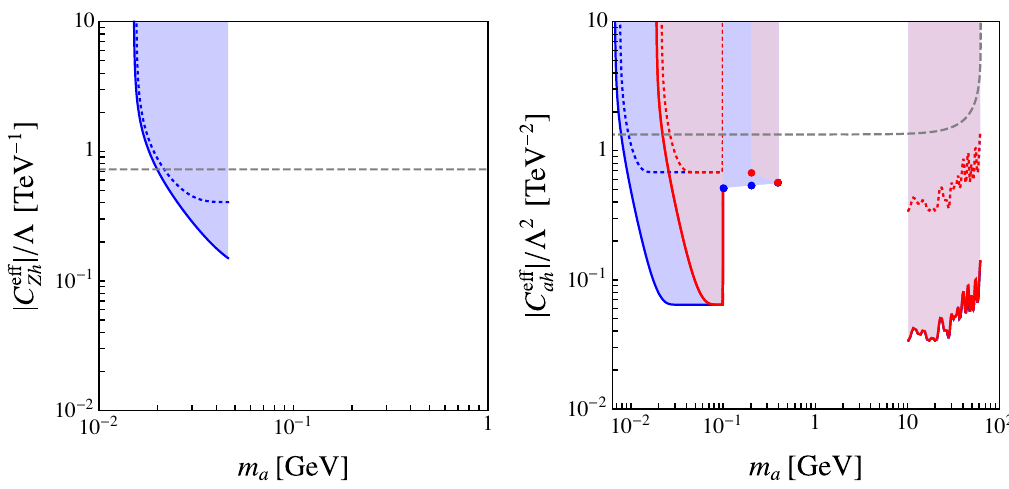
Figure 12 . Parameter space excluded by existing searches for h measurements of the pp h (cid:13)(cid:13) rate (low-mass region in the right panel), and by dedicated ! ! searches for h (cid:13)(cid:13) + (cid:13)(cid:13) in the mass range between 100 and 400 MeV (three points) and in the ! region m a = (10 62 : 5) GeV (right panel). Solid and dotted curves are obtained for Br( a (cid:0) and 0.1, respectively, while red and blue lines (and points) refer to The gray dashed lines indicate the model-independent bounds (5.11) and (5.16).